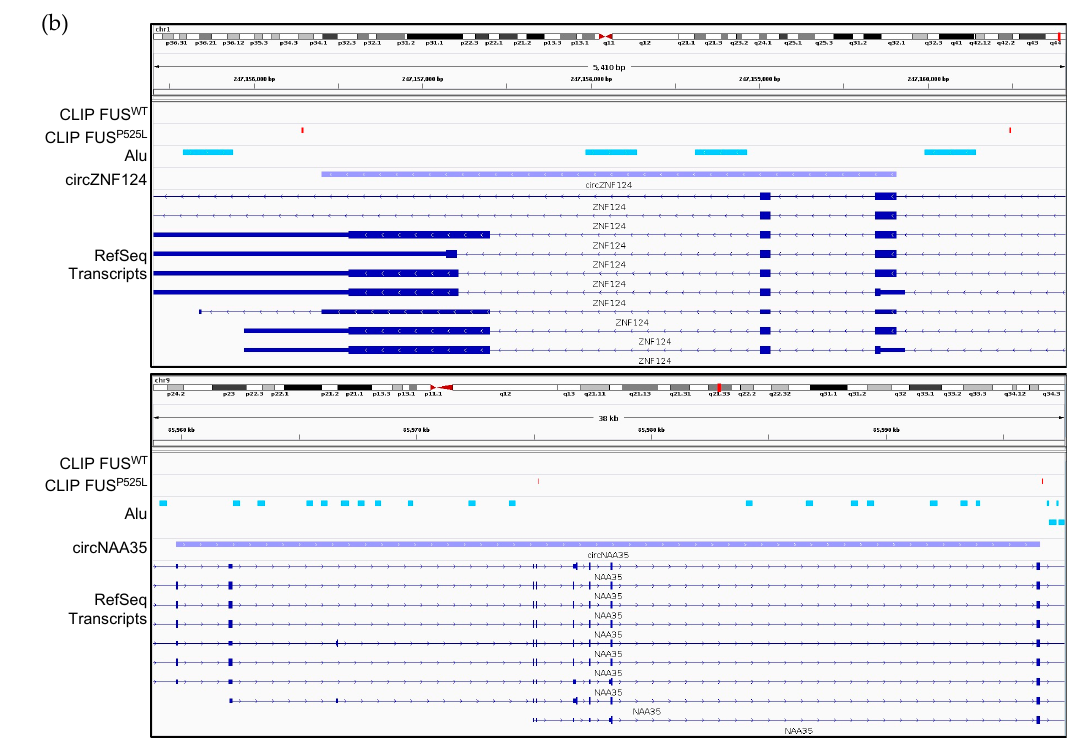
Figure 3. WT and mutant FUS binding in the intronic regions flanking motoneuronal circRNAs. ( a ) The left side of the table reports the one-sided Fisher’s exact test p -values describing the enrichment, with respect to unaffected circRNAs, of WT and mutant FUS binding sites (previously identified via PAR-CLIP; [44]) in downregulated (upper part) and upregulated (bottom part) circRNAs within 1 kb-long flanking intronic regions. The right side of the table reports the overlap between the circRNAs with WT or mutant FUS binding sites in the 1 kb flanking intronic regions and those hosting inverted Alu repeats in the same regions. CircRNAs were divided into downregulated, upregulated and unaffected upon FUS mutation. The deregulated circRNAs whose linear counterpart significantly varies in the same direction were excluded from this analysis, since it is less likely that FUS directly modulates their biogenesis. ( b ) IGV genome browser [60] tracks representing two circRNAs (circZNF124 and circNAA35) whose 1 kb-long flanking intronic regions contain both P525L FUS binding sites (red boxes) and inverted Alu repeats (light blue boxes).